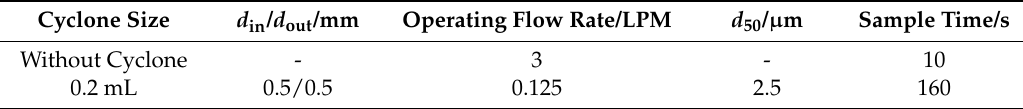
Table 2. Parameters for the cyclone separator test.